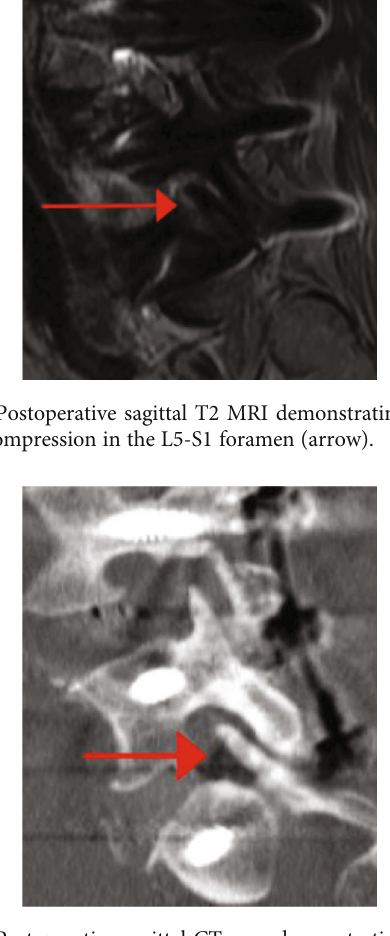
Figure 6: Postoperative sagittal CT scan demonstrating persistent L5 nerve root compression in the L5-S1 foramen